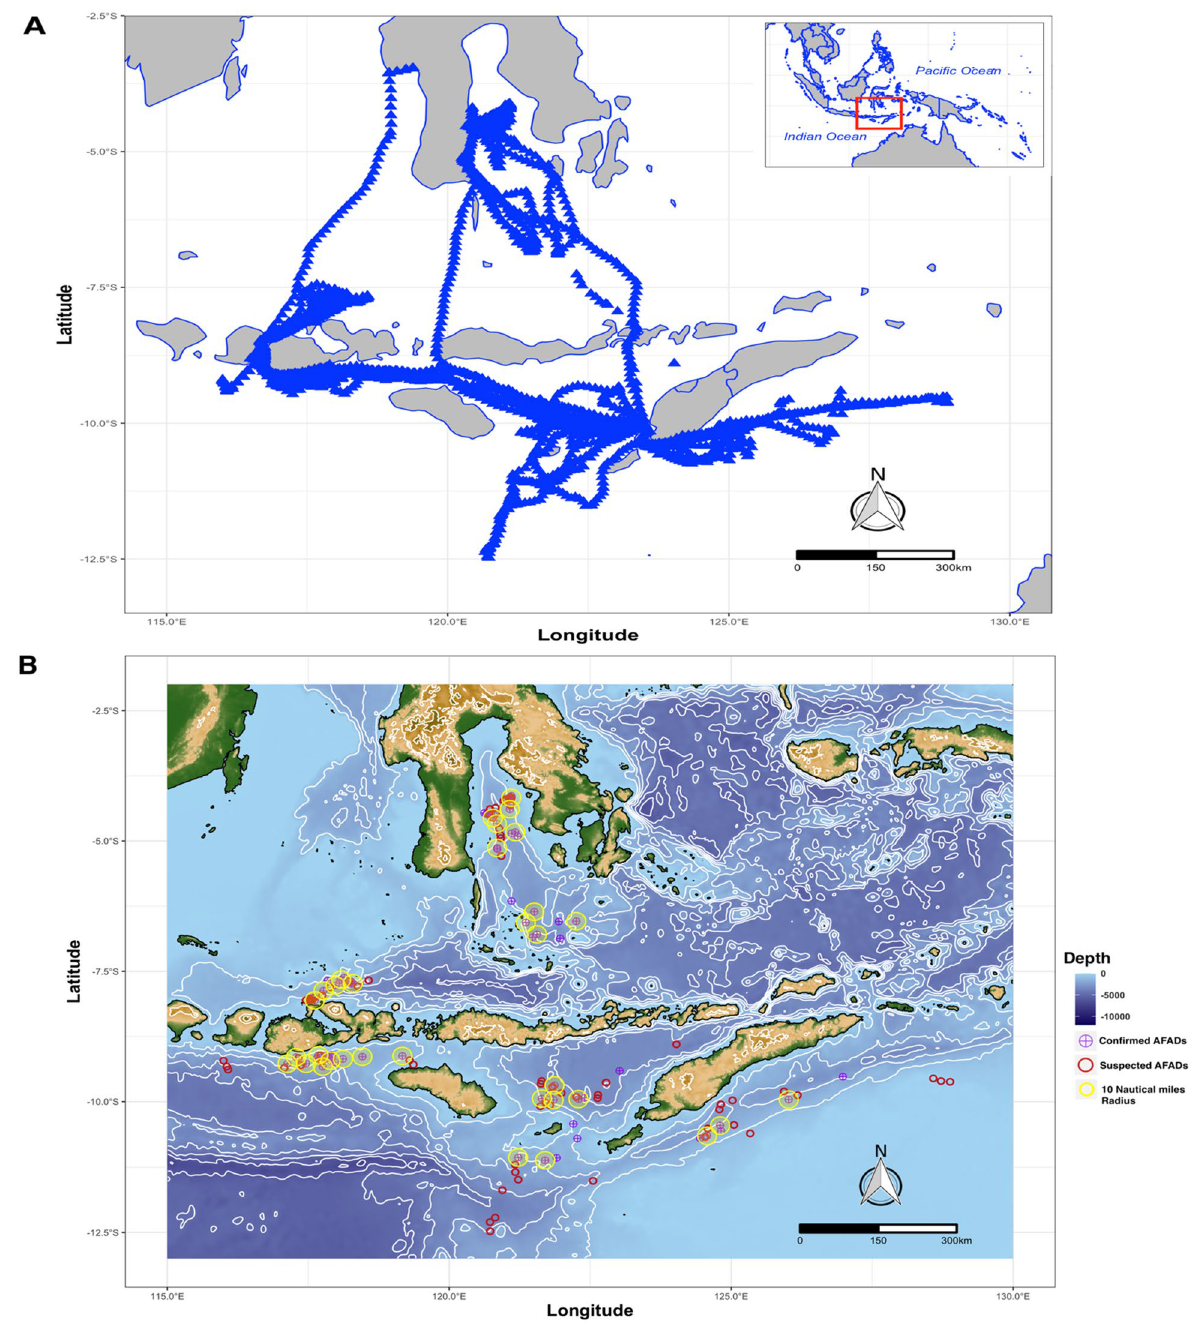
Figure 1. (A) Blue triangles indicate raw data of vessels’ tracking records, depicting vessel movement patterns; and (B) suspected, and confirmed FAD’s location with ten Nautical miles as indicated from confirmed FADs. Map made using R version 4.0.3 36 by utilizing marmap 37 and ggmap package 38 with bathymetry data extracted from ETOPO1 1 Arc-Minute Global Relief Model 39